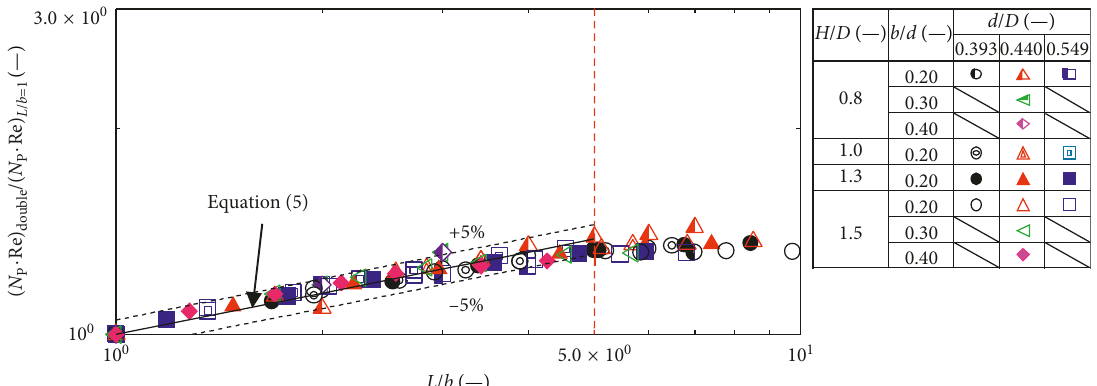
Figure 8: Correlation of power consumption for a double impeller. The solid line represents equation (5). The dotted lines represent the relative error of ± 5% from equation (5). The red dashed line represents L / b �